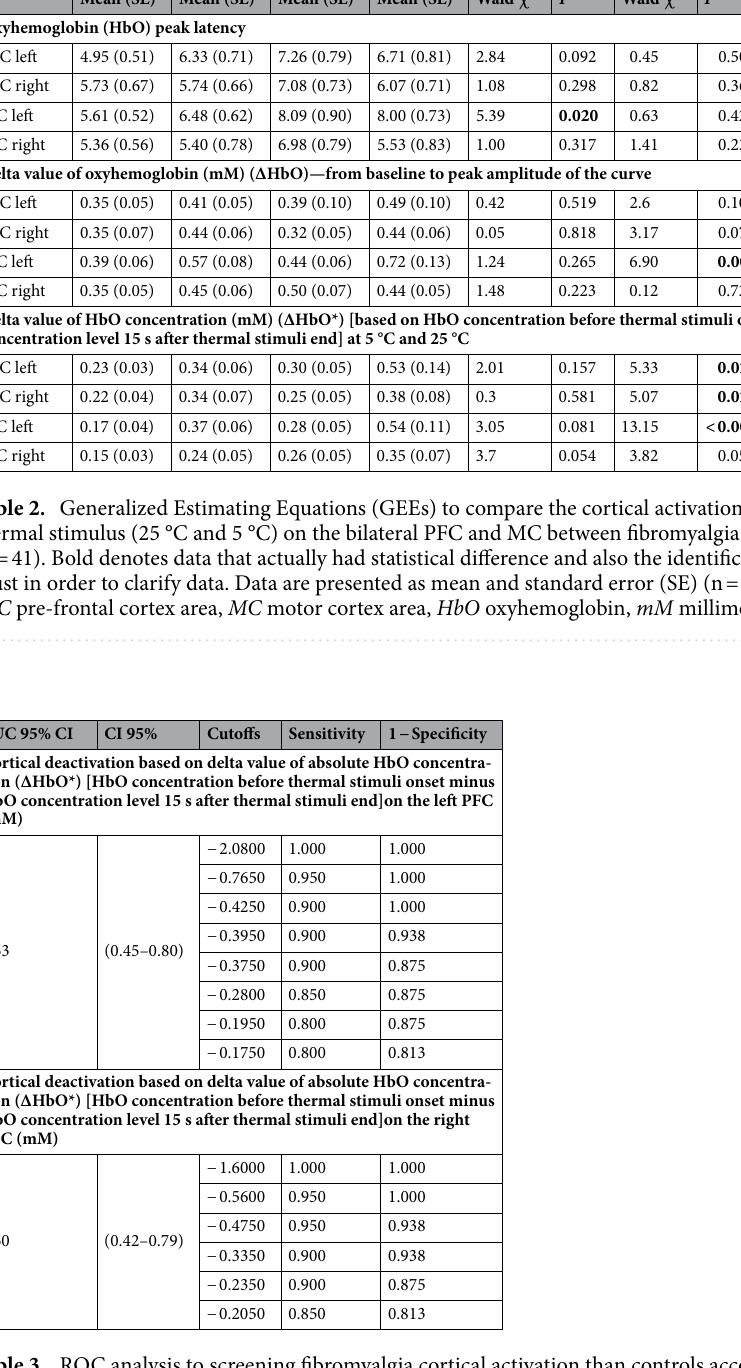
Table 3. ROC analysis to screening fibromyalgia cortical activation than controls according to the right and left PFC activation time based on the on ΔHbO* value (n = 42). AUC area under the curve, CI confidence interval, ROC receiver operator